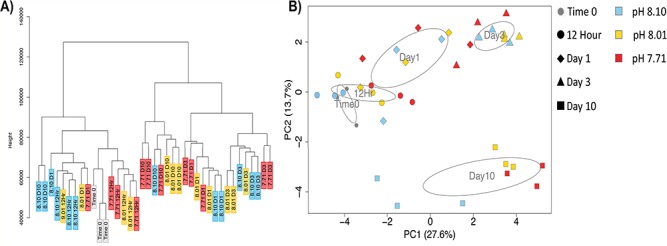
A) Hierarchical clustering of gene expression for individuals cultured at +4 °C. B) Biplot of the first two principle components, sample day is represented by icon shape while pH is designated by color.